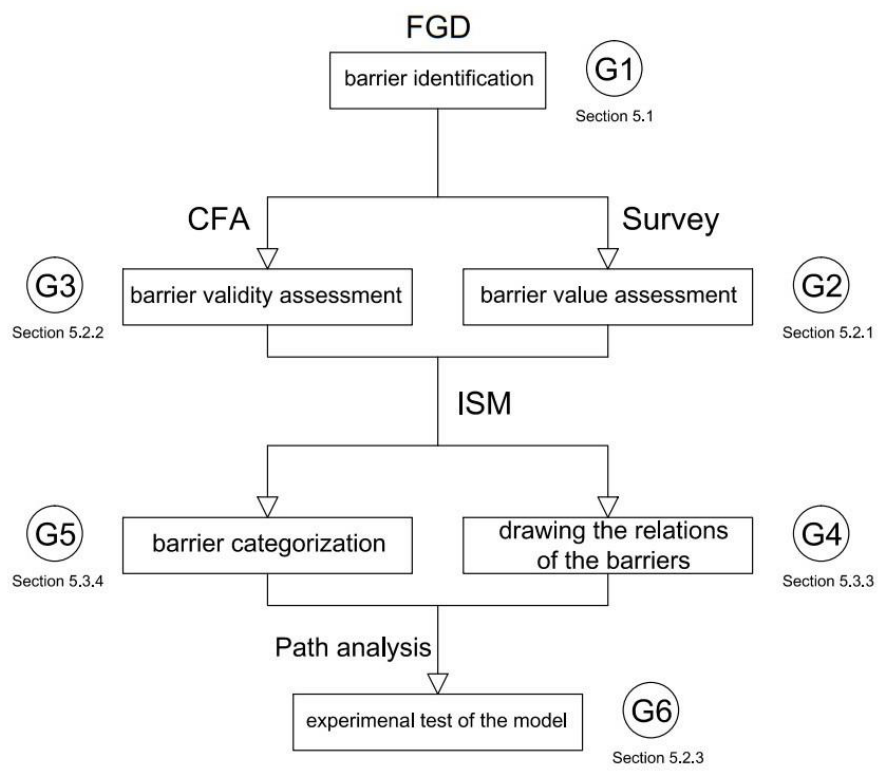
Figure 2. Flowchart of the study (G refers to research goals).